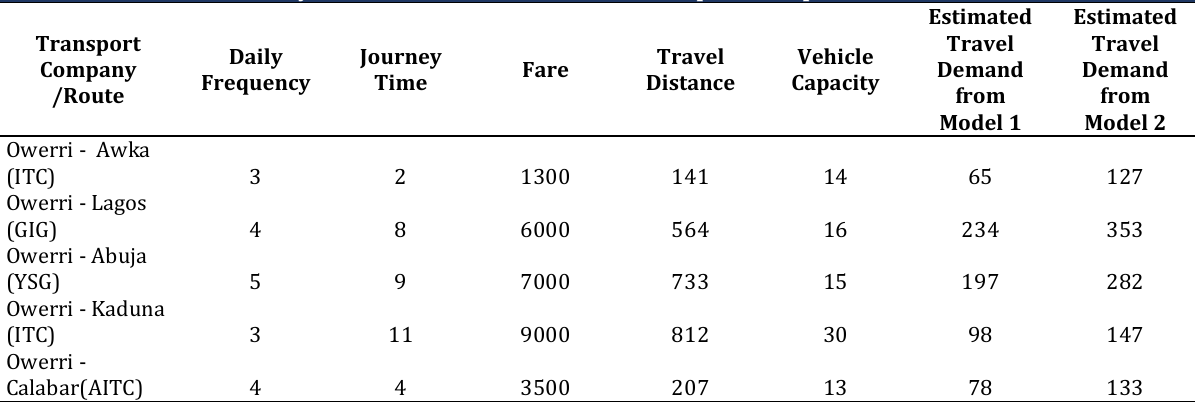
Table 3: Estimated Intercity Travel Demand of Selected Transport Companies in Owerri